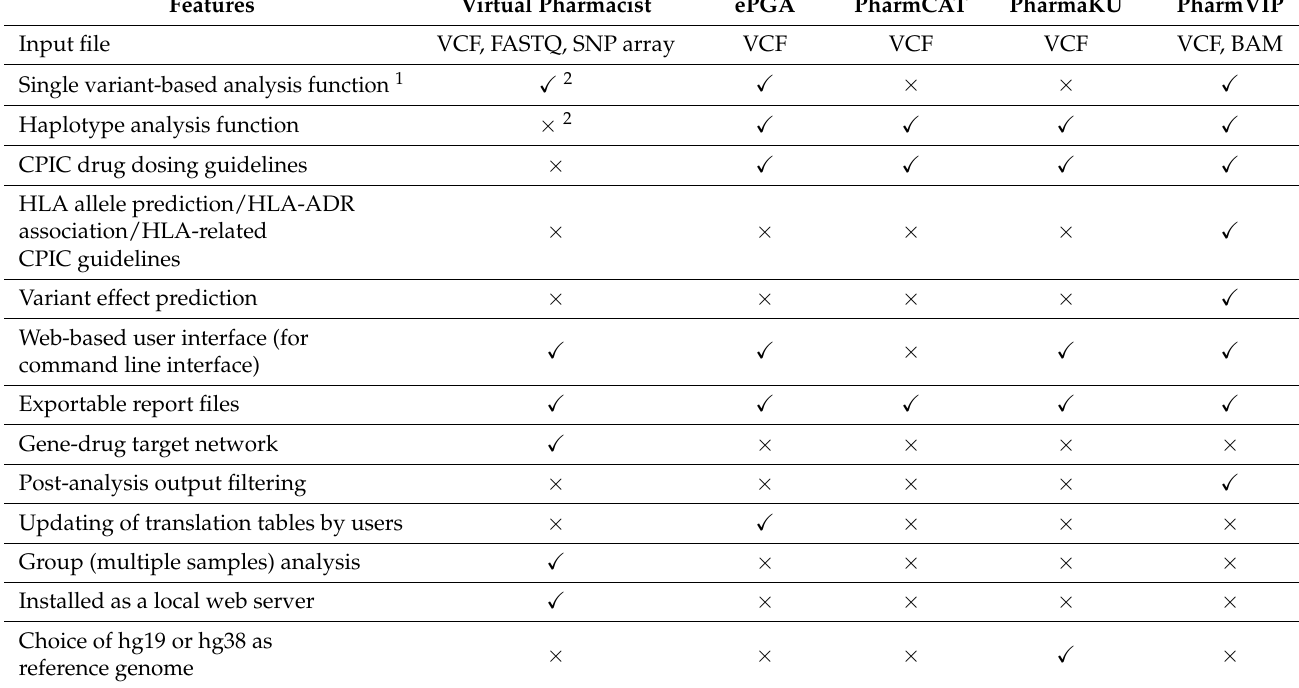
Table 2. Feature comparison of available pharmacogenomic variant analysis tools and